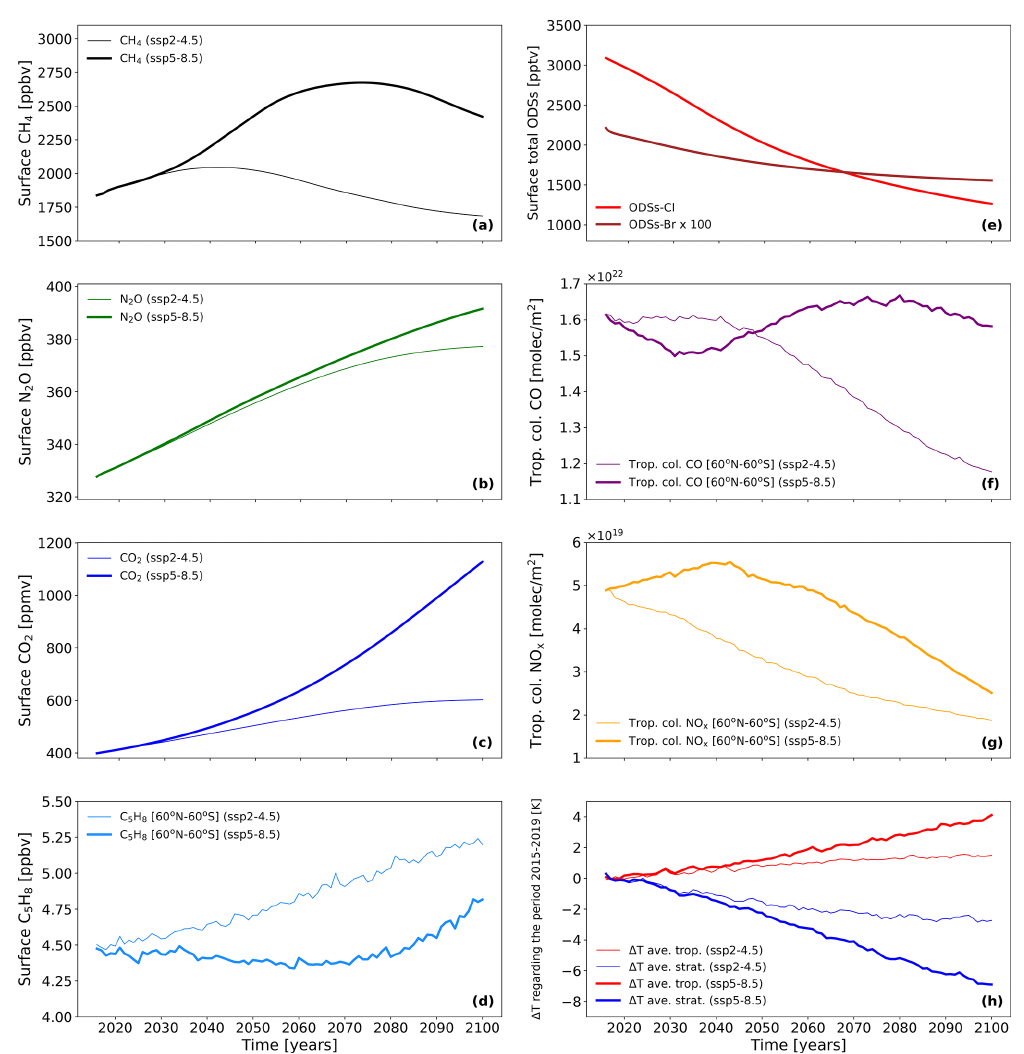
Figure 1. Annual mean evolution of drivers of ozone changes between 2015 and 2099 from both SSP2-4.5 (faded lines) and SSP5-8.5 (bold lines) – ODSs are presented as a single line, since their amounts are identical in both considered scenarios. This includes (a) global surface methane (CH 4 ) concentration [ppbv], (b) global surface nitrous oxide (N 2 O) concentration [ppbv], (c) global surface carbon dioxide (CO 2 ) concentration [ppmv], (d) near-global (60 ◦ N–60 ◦ S) surface isoprene (C 5 H 8 ) concentration [ppbv], (e) surface total organic chlorine (red line) and bromine ( × 100; dark-red line) ODS concentrations [pptv], (f) near-global (60 ◦ N–60 ◦ S) tropospheric carbon monoxide (CO) col- umn [molec.cm − 2 ], (g) near-global (60 ◦ N–60 ◦ S) tropospheric nitrogen oxide (NO x ) column [molec.cm − 2 ], and (h) global mean changes in averaged tropospheric (red line) and averaged stratospheric (blue line) temperature ( (cid:49)T ) regarding its mean for the period